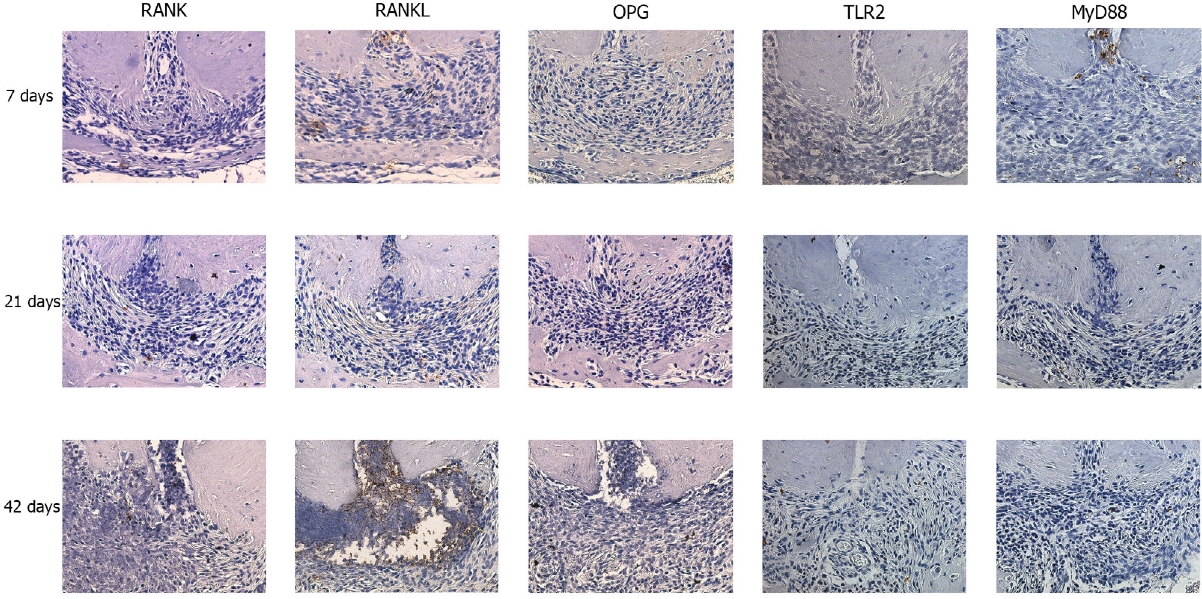
Figure 4- Representative photomicrographs obtained at 7, 21 and 42 d after the experimental induction of periapical lesions in wild-type mice. The presence or absence of immunostaining was determined by immunohistochemistry using RANK, RANKL, OPG, TLR2 and